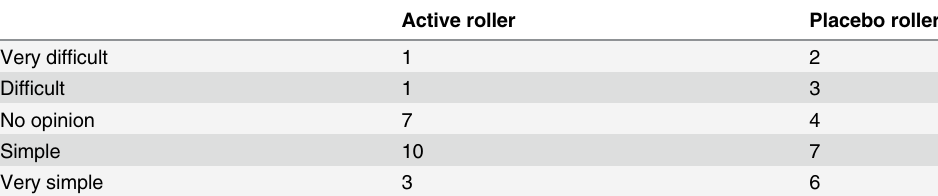
Table 3. Participant ’ s perception on simplicity of roller